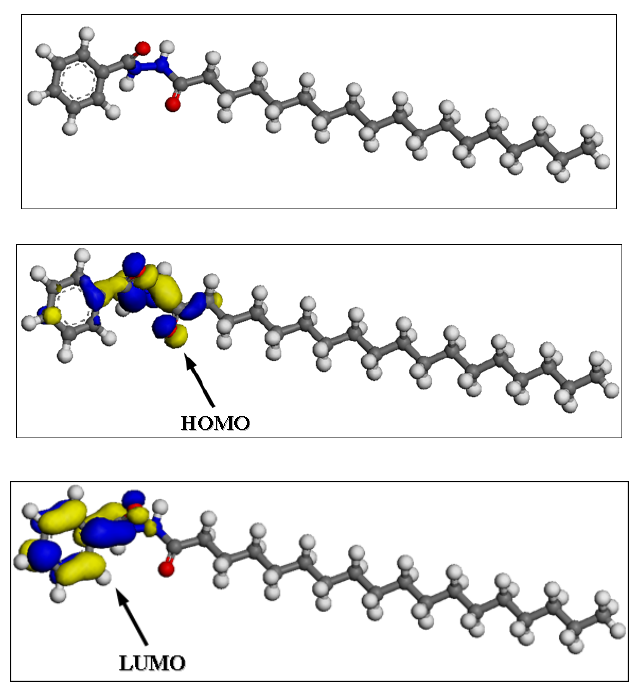
Figure 3. Optimized geometric structure, HOMO and LUMO of N -(benzoyl) stearic acid